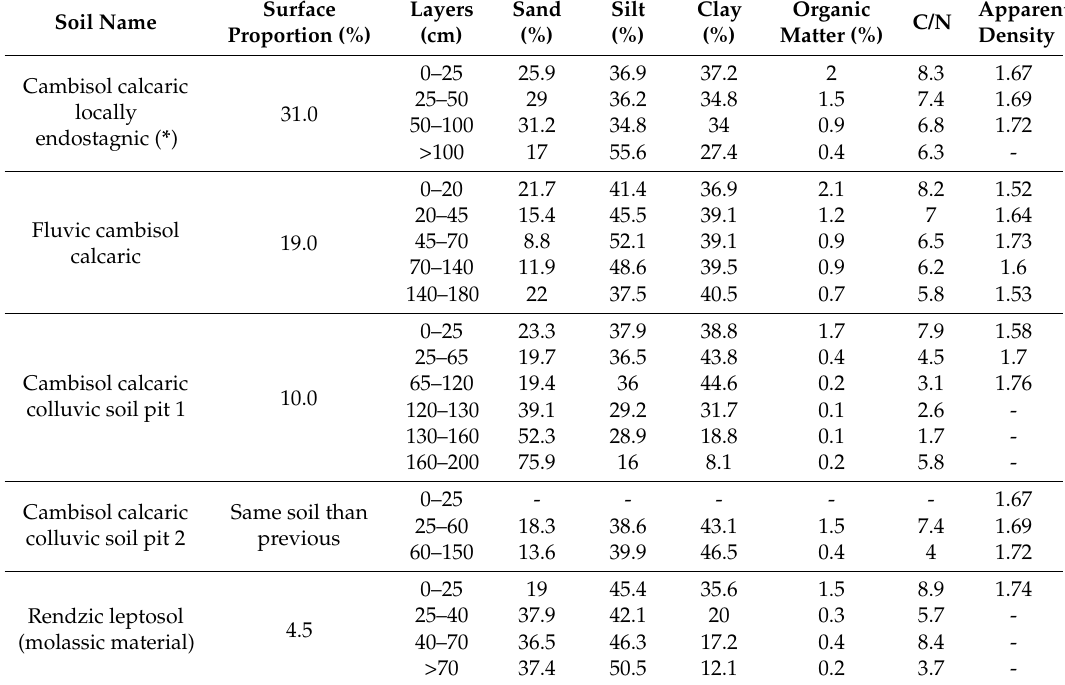
Figure 2. Details of the Topography Nitrogen Transfer and Transformation (TNT2) model spatial input ( a ) with “ a-priori ” Soil Water Holding Capacity (SWHC) parameters derived from soil map and soil survey and the Topographic saturation index (TSI) value (Equation (1)) derived from Digital Elevation Model; ( b ) Simulation of maximum LAI (LAX) for the wheat (2007) and the sunflower (2008) with “ a-priori ” soil parameters; ( c ) LAX derived from satellite series and aerial photography of the sunflower crop cover in July 2008. The red polygon highlight the simulations and observations for the year 2008. Table 1. Soil types and physical characteristics in Auradé catchment (source from Sol-Conseil and EcoLab). Soil Name Soil